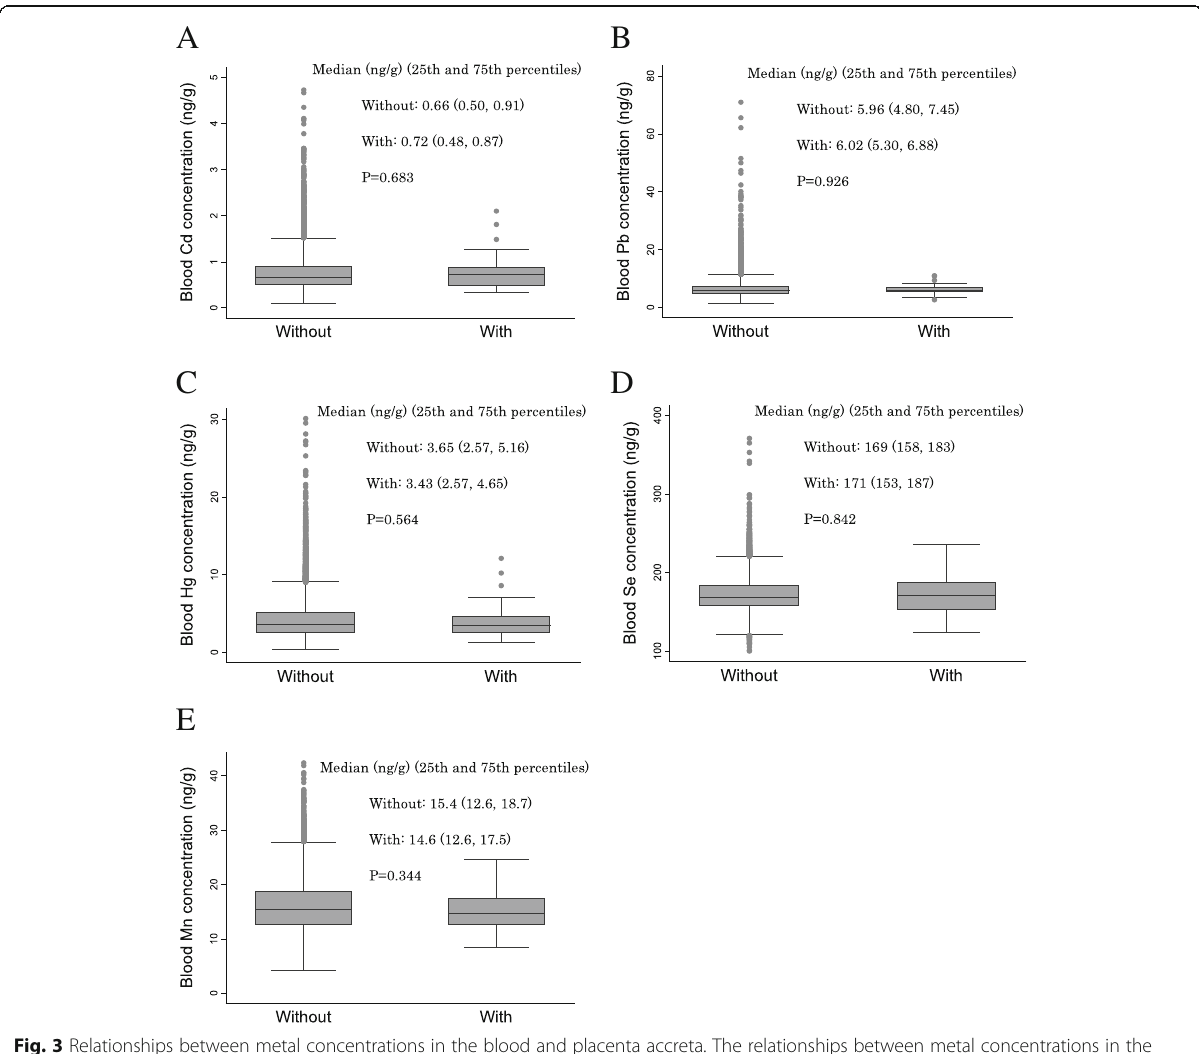
Fig. 3 Relationships between metal concentrations in the blood and placenta accreta. The relationships between metal concentrations in the second/third trimester (T2) blood and placenta accreta are shown. A box plot displays a box bordered at the 25th and 75th percentiles of the variable on the y-axis with a median line at the 50th percentile of each metal concentration. p values were calculated using the Mann-Whitney U test. a Relationship between Cd concentration and placenta accreta. b Relationship between Pb concentration and placenta accreta. c Relationship between Hg concentration and placenta accreta. d Relationship between Se concentration and placenta accreta. e Relationship between Mn concentration and placenta accreta. Cd, cadmium; Pb, lead; Hg, mercury; Se, selenium; Mn,